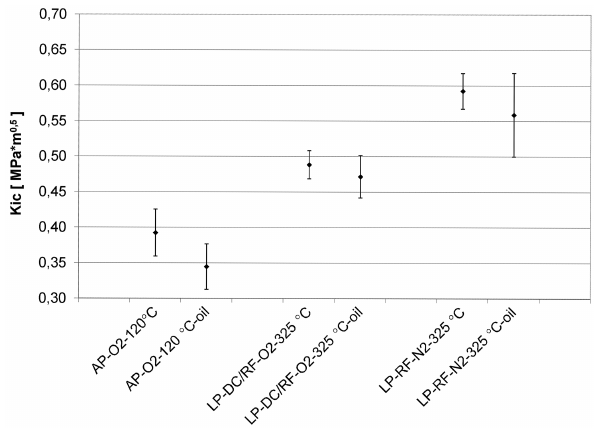
Figure 5. SFB toughness behaviour with and without contact to AK20 silicone